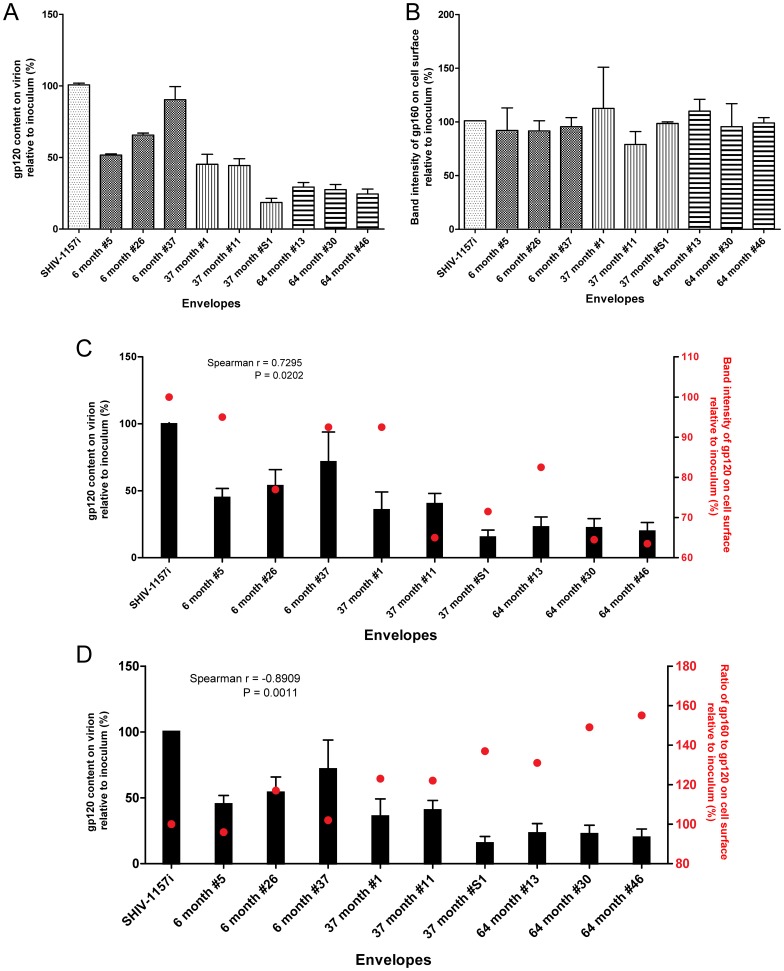
Quantity of envelope on cell surfaces and gp120 on virions.(A) Quantities of gp120 on virions expressing selected V1-V5 region from each time point. (B) Relative levels of 293T cell surface-associated gp160. (C) Correlation between the levels of virion-associated gp120 (black bars) and 293T cell surface-associated gp120 (red dots). (D) Correlation between the levels of virion-associated gp120 (black bars) and the ratio of 293T cell surface-associated gp160–120 (red dots).